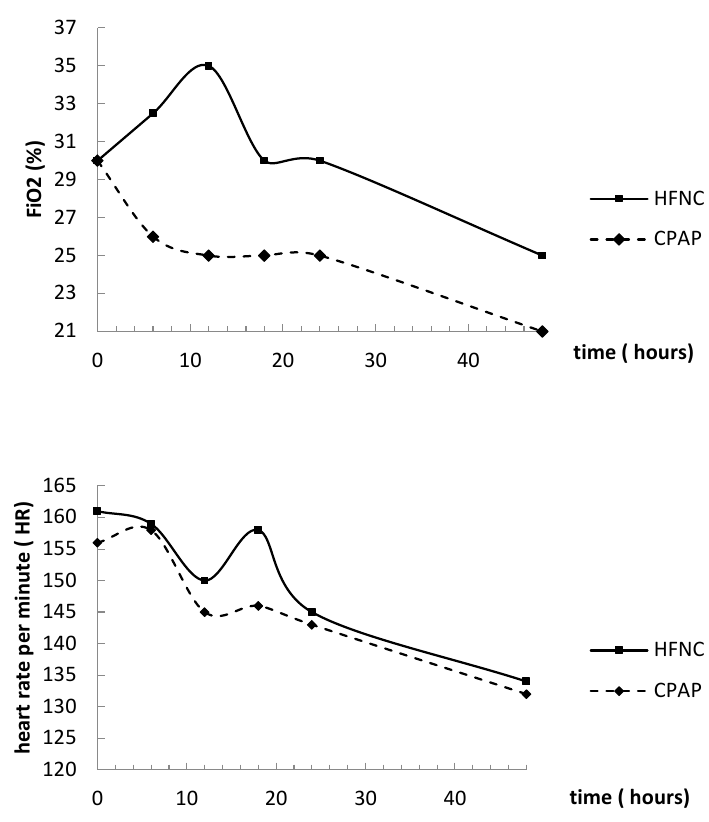
Figure 1. Median respiratory rate (RR), FiO2 and heart rate (HR) during 48 h of treatment. RR and FiO2 decreased significantly more in the CPAP group. HR decreased equally in both groups. FiO2 declined over time in the CPAP group. In the HFNC group, FiO2 increased during the first 12 h and decreased for the rest of the treatment (Figure 1). The difference in FiO2 development between the groups was highly significant ( p < 0.01). Age had a significant effect on FiO2, and was thus kept in the model.